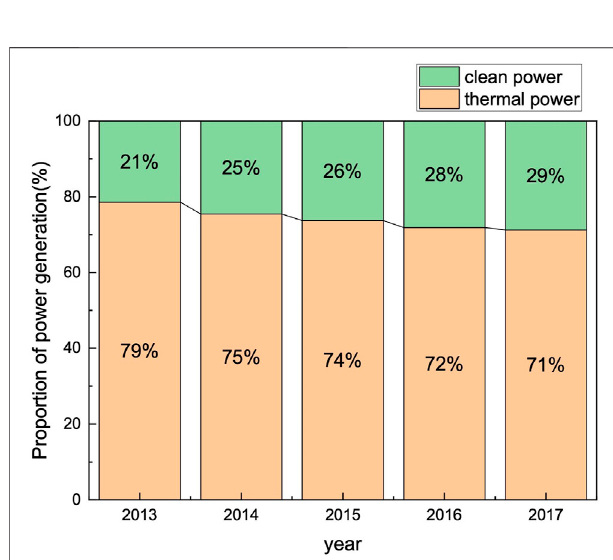
FIGURE 2 | Proportion of power generation (%) 2013 –